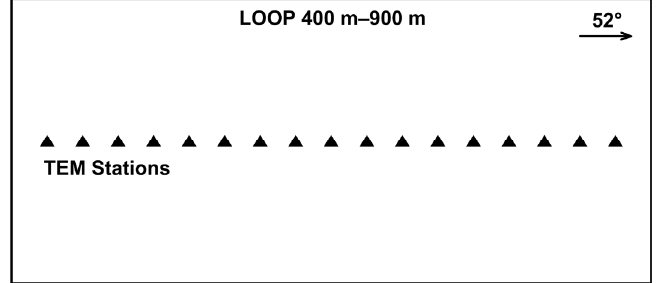
Figure 3. Schematic diagram of transmitting loop and TEM stations.